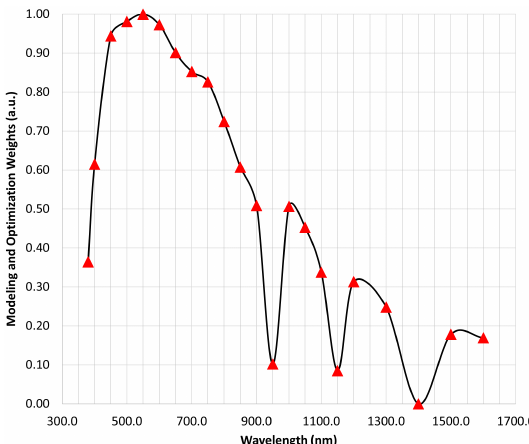
Figure 1. Solar spectrum in the visible and near-infrared regions. Relative weights for wavelengths used in the optimization and analyses are shown with the red triangles